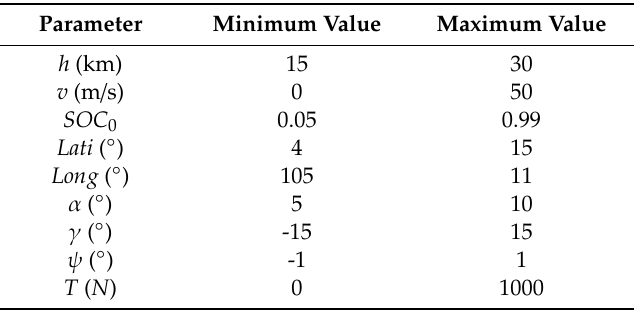
Table 4. The constraints of